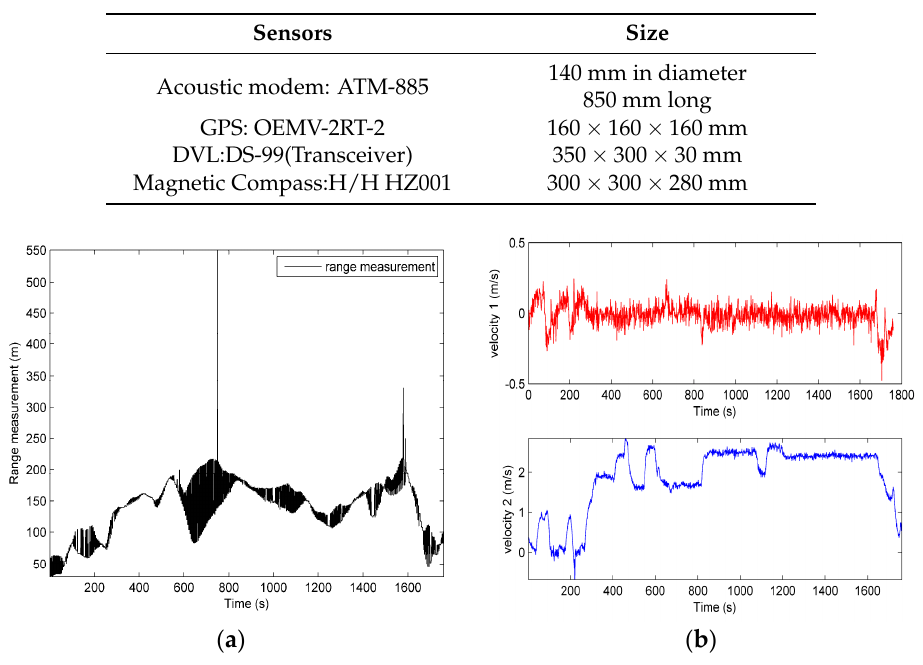
Table 5. The size of employed sensors.